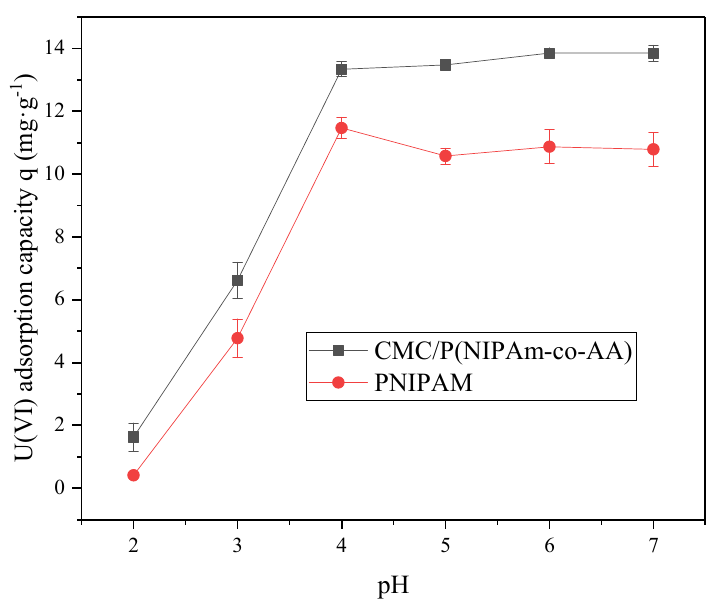
Figure 6. Effect of pH on U(VI) adsorption by CMC/P (NIPAM-co-AA) and PNIPAM. Figure 6. E ff ect of pH on U(VI) adsorption by CMC / P (NIPAM-co-AA) and